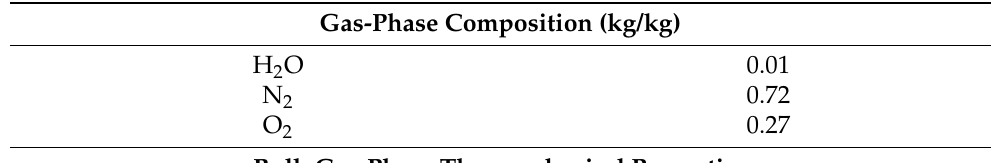
Table 3. Gas-phase composition and thermophysical properties and solid thermophysical properties used in the